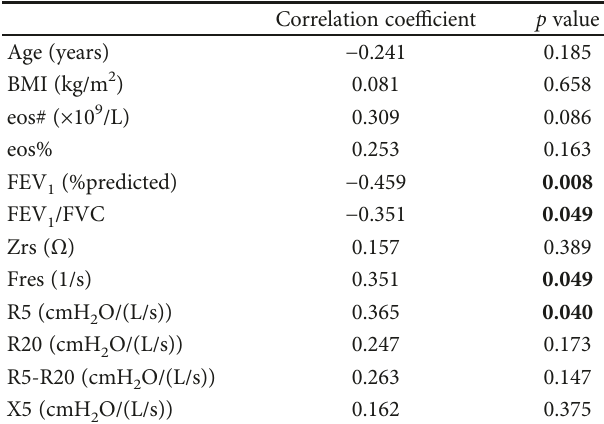
Figure 1: Plasma FSTL1 levels in controls and asthmatics. (a) Plasma FSTL1 levels in controls and asthmatics. (b) log controls and asthmatics from plasma. Data is represented as mean ± SD. Table 2: Spearman rank correlation analysis to identify factors FSTL1 in associated with log 10